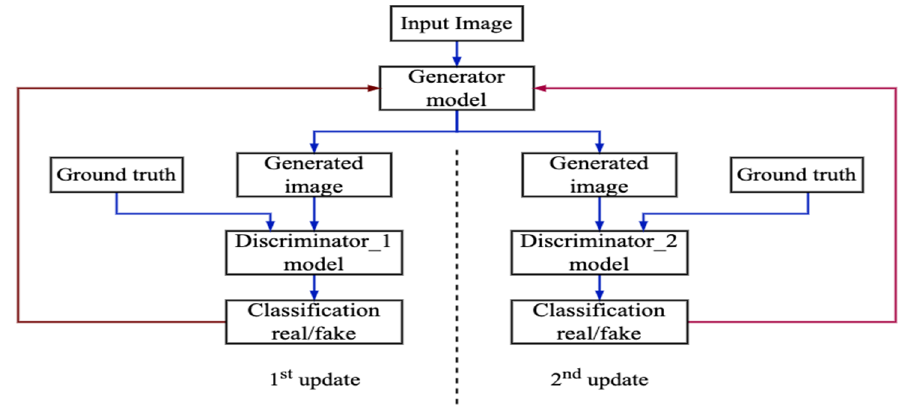
Figure 2. Illustration of updating the generator twice in an iteration with a different discriminator at each